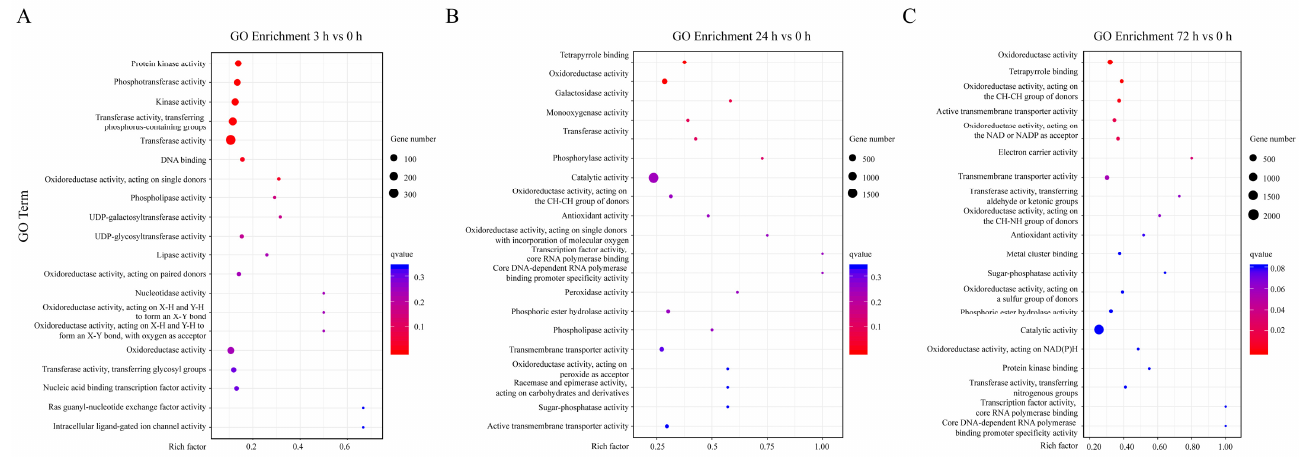
Figure 4. GO enrichment analysis of DEGs in different groups. ( A ) GO enrichment analysis of the DEGs in response to sucrose treatment for 3 h and 0 h. ( B ) GO enrichment analysis of the DEGs in response to sucrose treatment for 24 h and 0 h. ( C ) GO enrichment analysis of the DEGs in response to sucrose treatment for 72 h and 0 h. The dots indicate the number of DEGs, and the color scale indicates the q